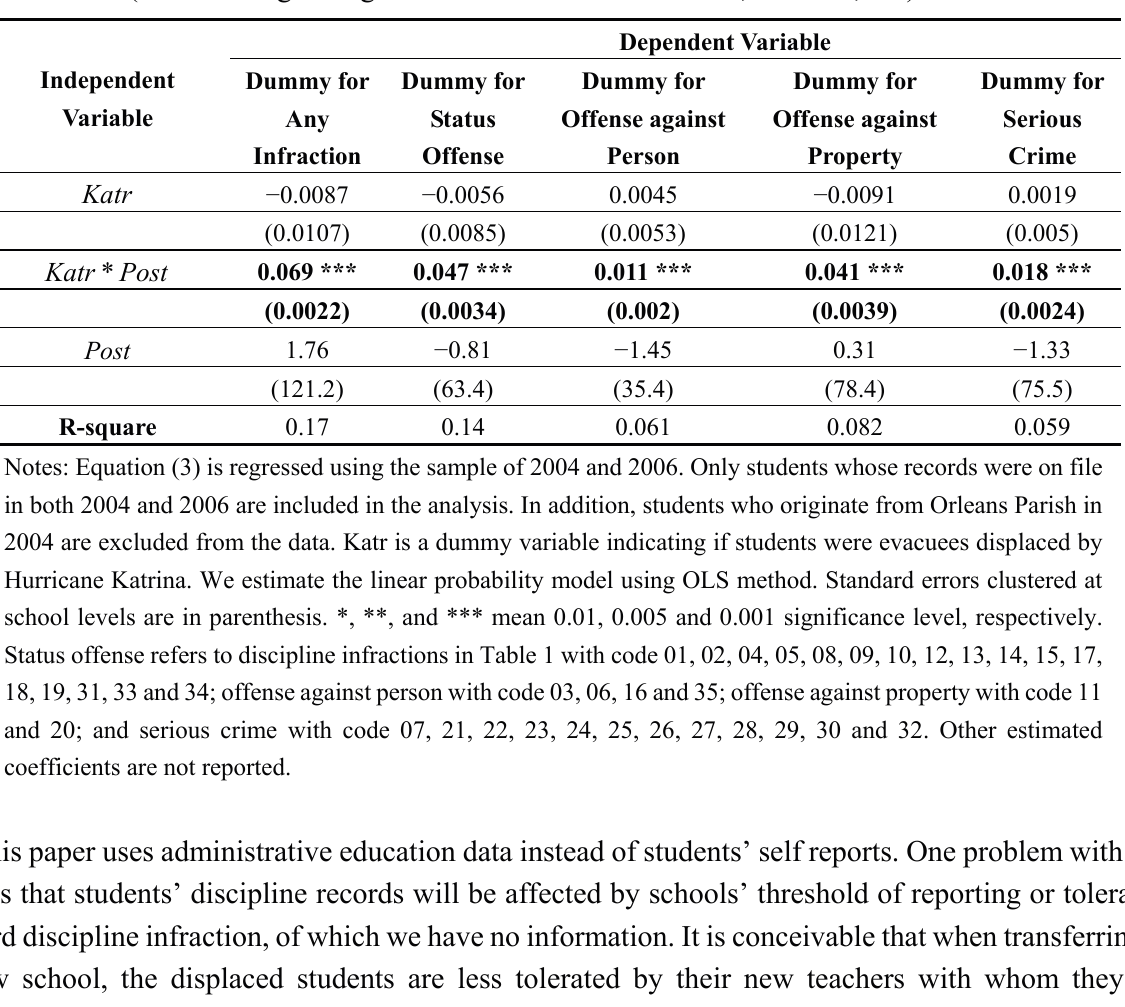
Table 7. Effect of Hurricane Katrina on displaced students’ likelihood of discipline infraction (students originating from Orleans Parish excluded, N =